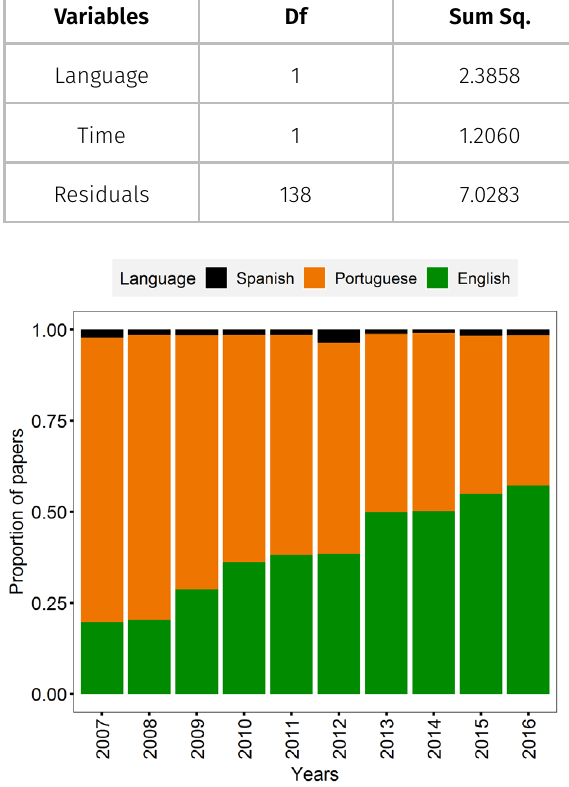
Table I. Relationship among the impact factor (intercept, dependent variable), official language of journals (English-only and multilanguage) and time (both employed as factors). Journal’s impact factors were statistically related to language and time ( P < 0.05). Sum Sq.